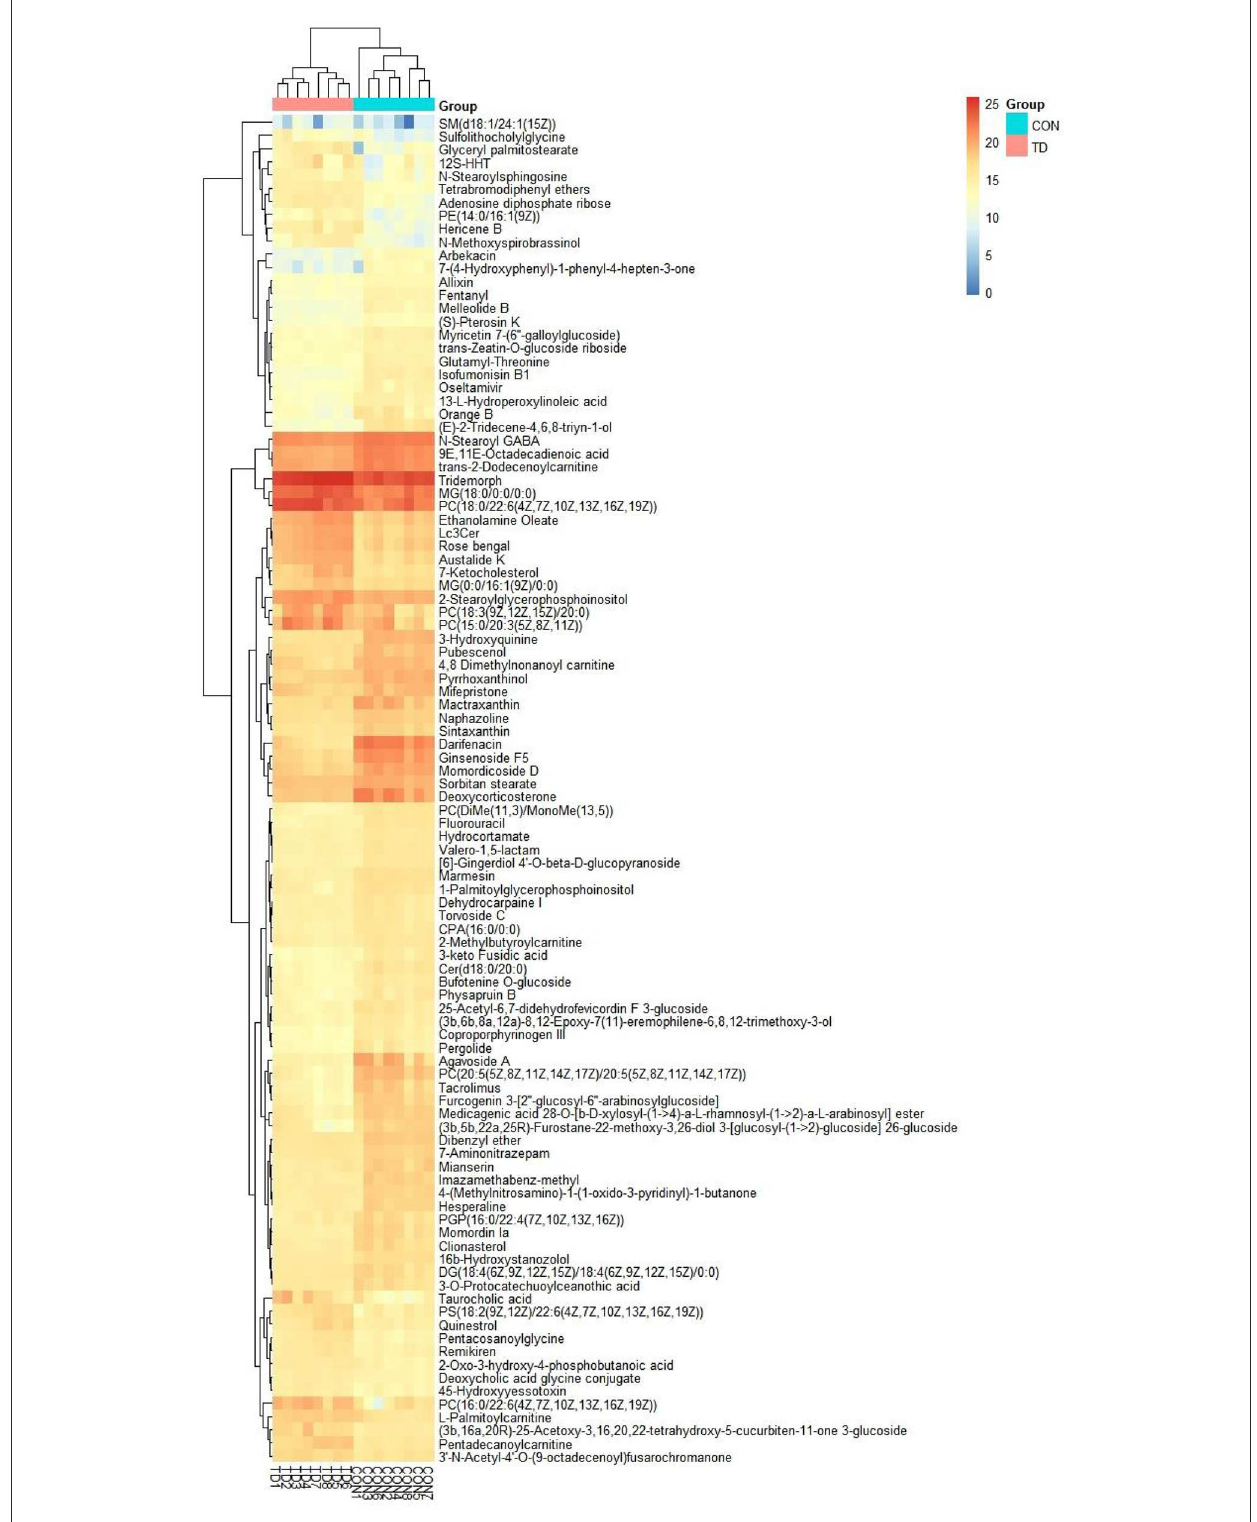
FIGURE2 Heatmap revealed the differential metabolites in liver exposed to thiram. The color in the heatmap indicates the normalized relative abundance of each metabolite.